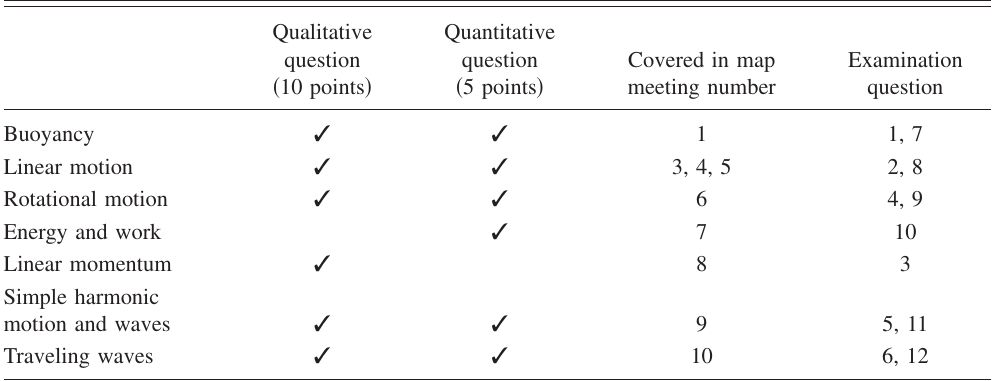
TABLE IV. Overview of topics covered in map meetings and the examination. The second map meeting covered symbols and units only, and hence did not belong to a specific